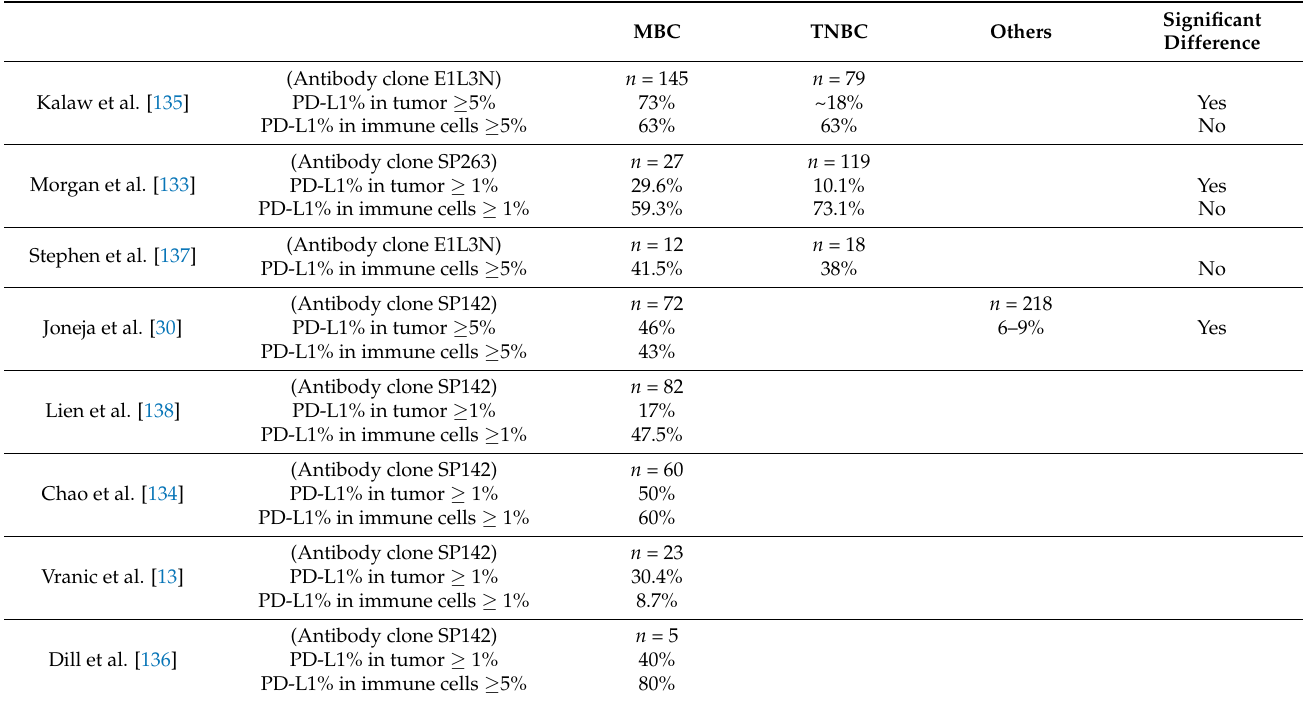
Table 1. Programmed cell death ligand-1 (PD-L1) expression in tumor cells and tumor microenvironment of metaplastic breast cancer, in some cases comparing data with other